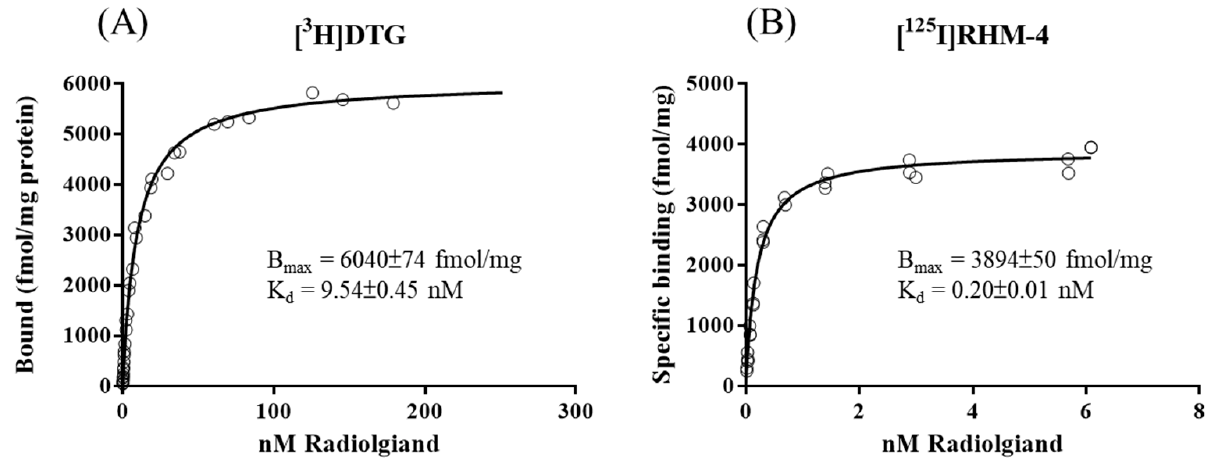
Figure 1. Saturation binding curves of [ 3 H]DTG ( A ) and [ 125 I]RHM-4 ( B ) on SD rat liver membranes. Both groups were performed with n = 3.